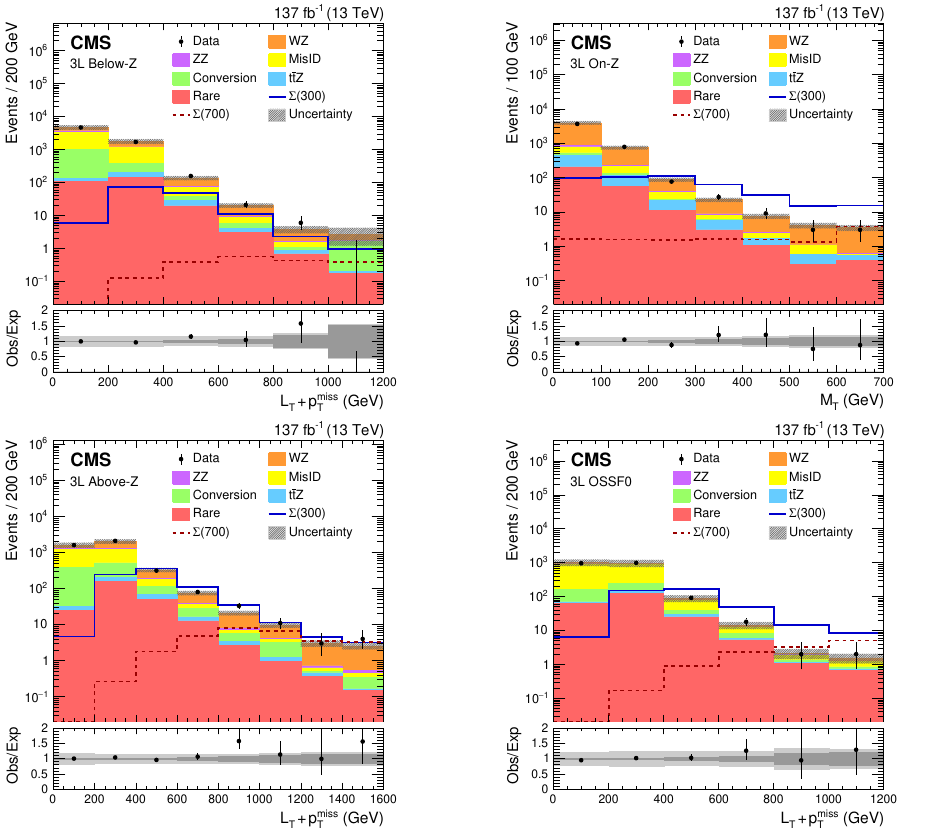
Figure 3 . Type-III seesaw signal regions in 3L below-Z (upper left), on-Z (upper right), above- Z (lower left), and OSSF0 (lower right) events. The total SM background is shown as a stacked histogram of all contributing processes. The predictions for type-III seesaw models with (cid:6) masses of 300 and 700 GeV in the (cid:13)avor-democratic scenario are also shown. The lower panels show the ratio of observed to expected events. The hatched gray bands in the upper panels and the light gray bands in the lower panels represent the total (systematic and statistical) uncertainty of the backgrounds in each bin, whereas the dark gray bands in the lower panels represent only the statistical uncertainty of the backgrounds. The rightmost bins contain the over(cid:13)ow events in each distribution.